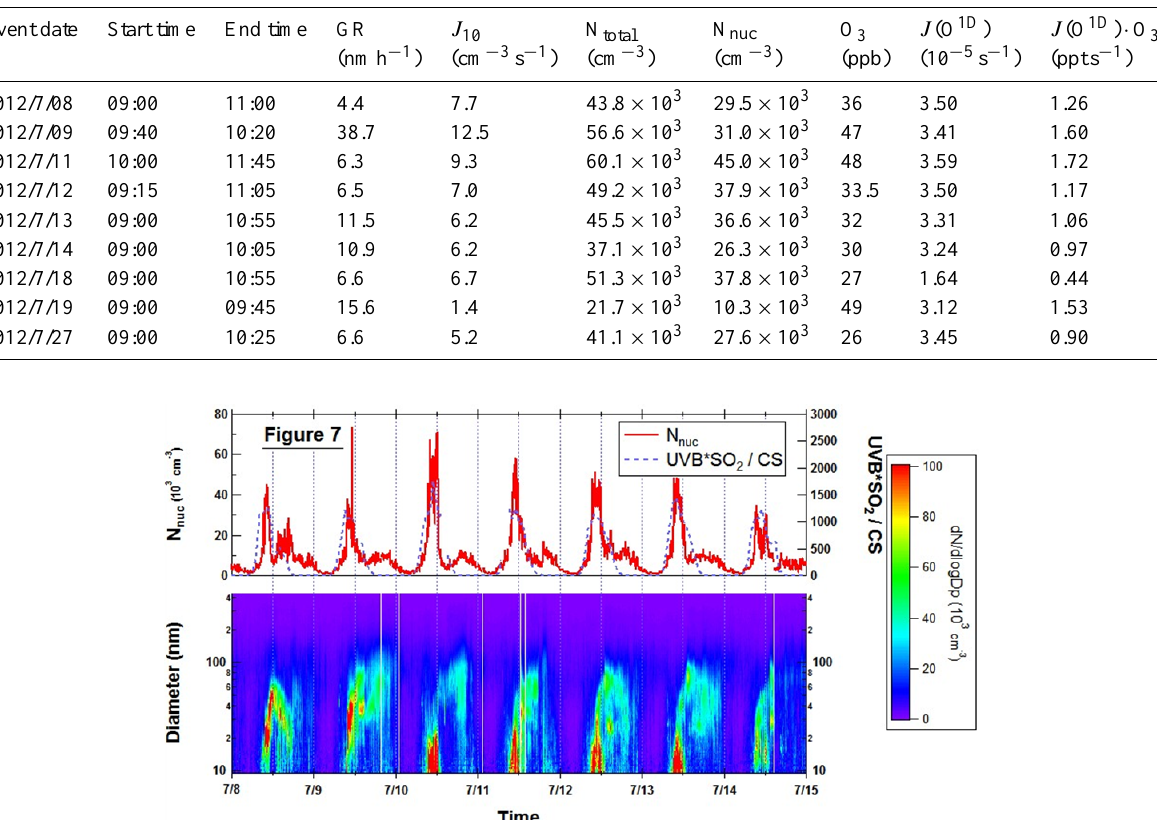
Table 3. Summary of averaged particle number concentration, growth rate, formation rate and ozone photolysis measurements for NPF events. Note: start and end time refer to the period of nucleation mode particles growing through 25nm, which are used to calculate the growth rate (GR).